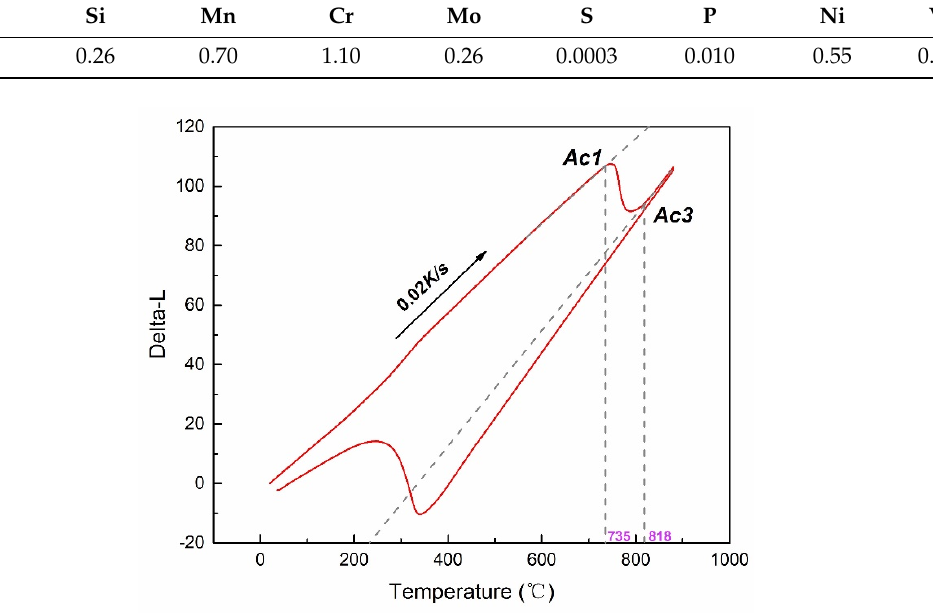
Figure 1. The dilatometric curve of the experimental MCLA Fig. 1. The dilatometric curve of the experimental MCLA steel. 81